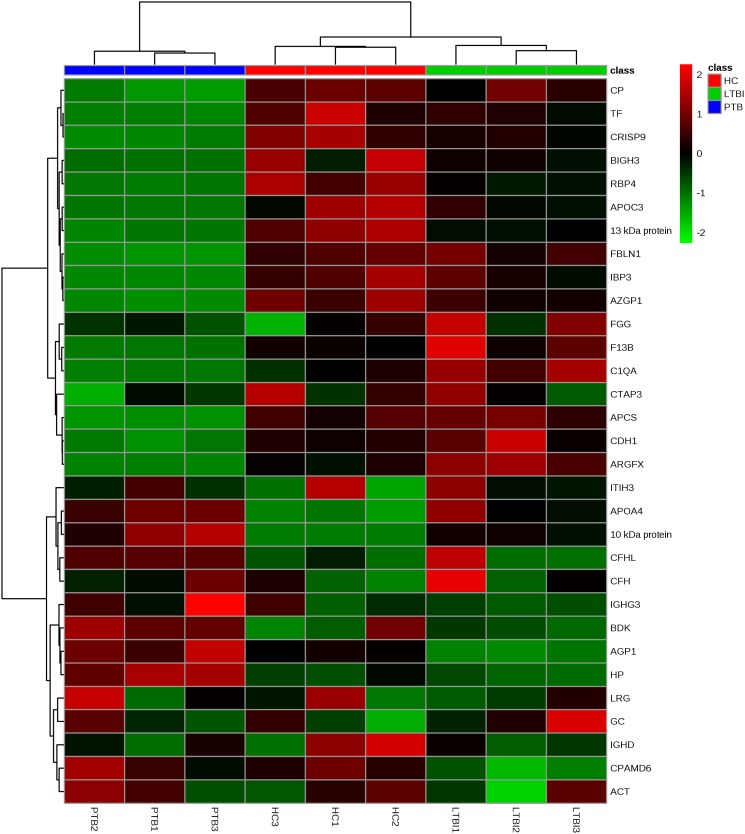
Hierarchical cluster analysis of the 31 differentially expressed proteins. Hierarchical cluster analysis was performed to determine whether the 31-protein profile could reflect the different statuses of M.TB infection. It showed that the nine pooled samples were successfully clustered into three groups, and each group matched exactly to the clinical grouping of PTB, LTBI, and HC. PTB, pulmonary TB; LTBI, latent tuberculosis infection; HC, healthy control.